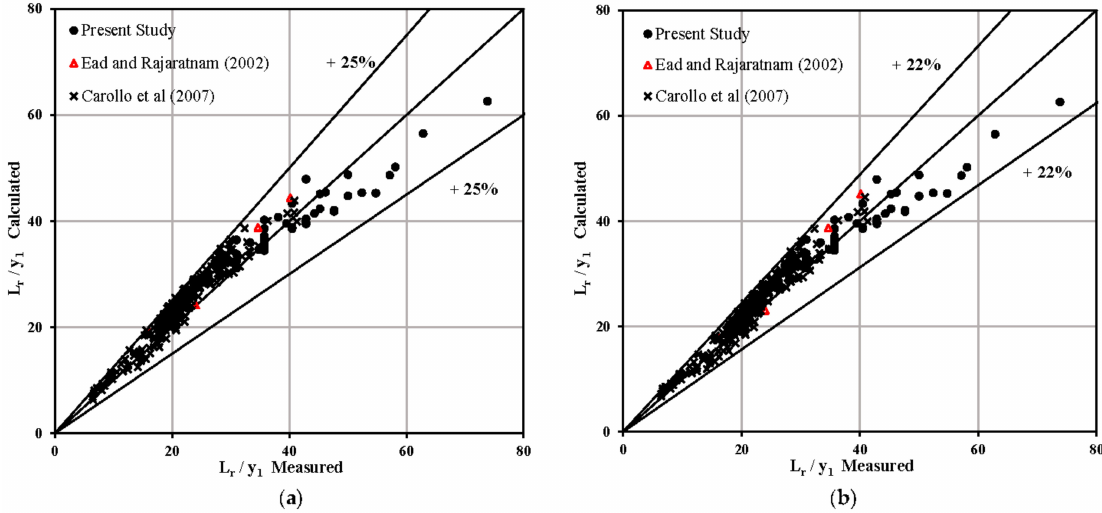
Figure 9. Comparison between the measured values of the ratio L r / y 1 and ( a ) results from Equation (16), ( b ) results from Equation